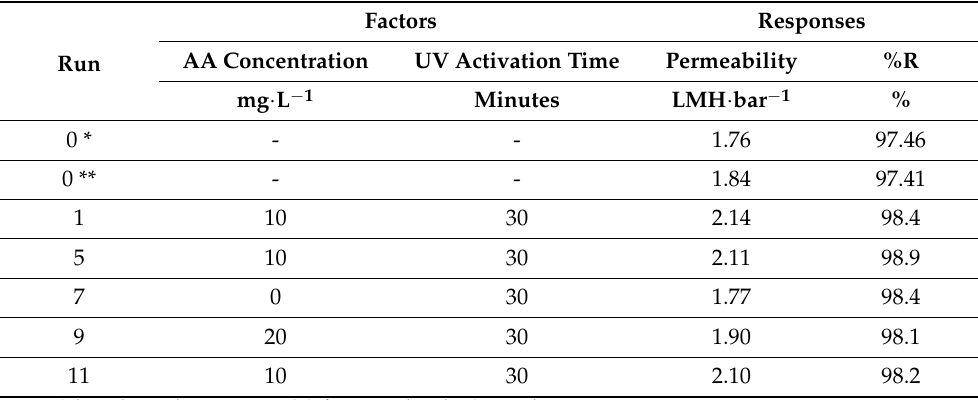
Table 2. Effects of acrylic acid concentration on permeability and salt rejection.